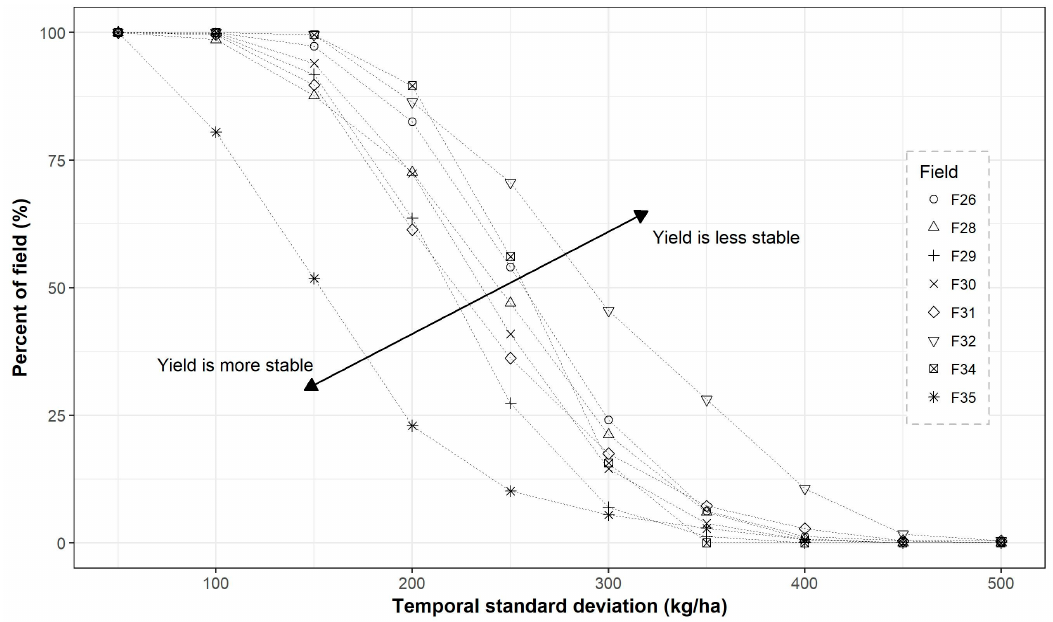
Figure 7. Percentage of field area affected by temporal instability of yield for eight cotton fields in the Southern High Plains 2000–2003.